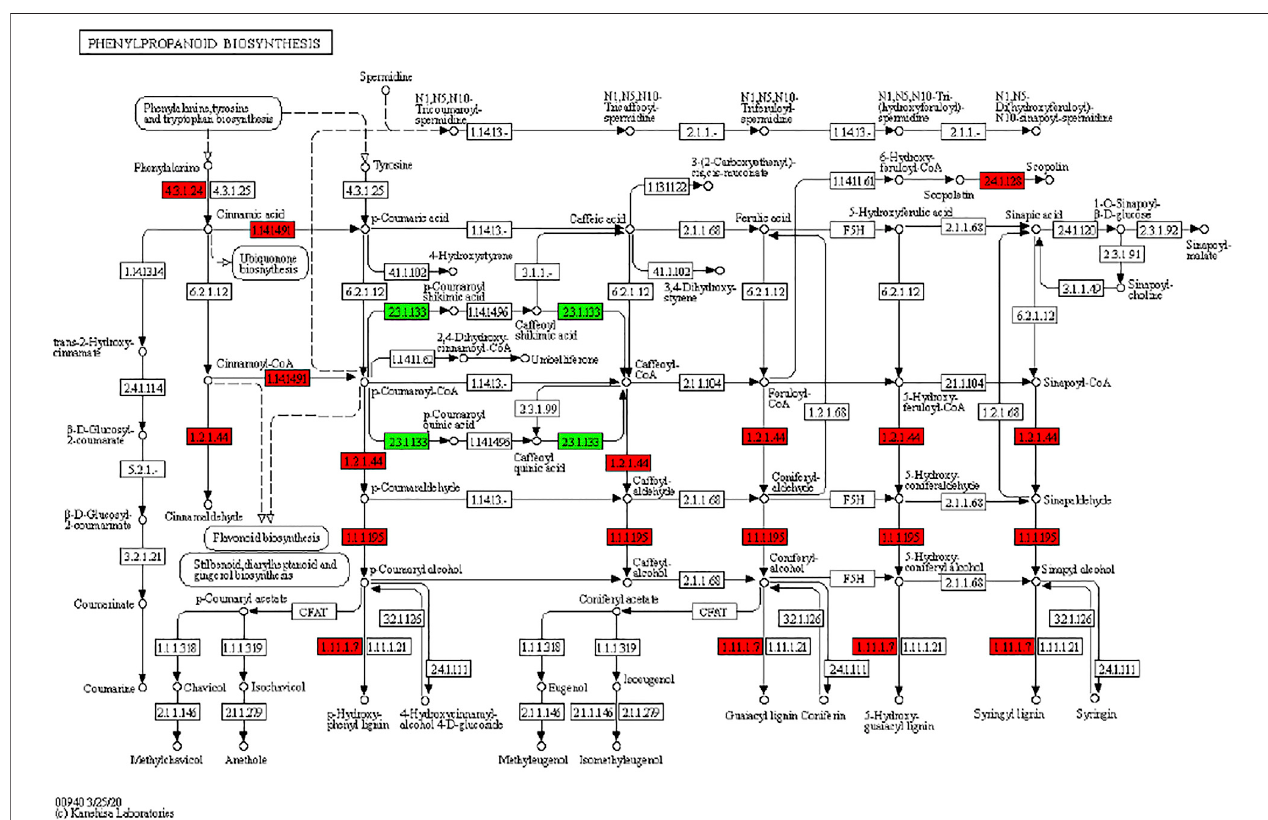
FIGURE4| Differentialregulationofphenylpropanoidbiosynthesispathwayin M.nana peelunderthein fl uenceofUV-Cirradiationascomparedtocontrol.Number in the boxes represent E.C. numbers of the enzymes. Red and green color indicates upregulation and downregulation of genes in response to UV-C